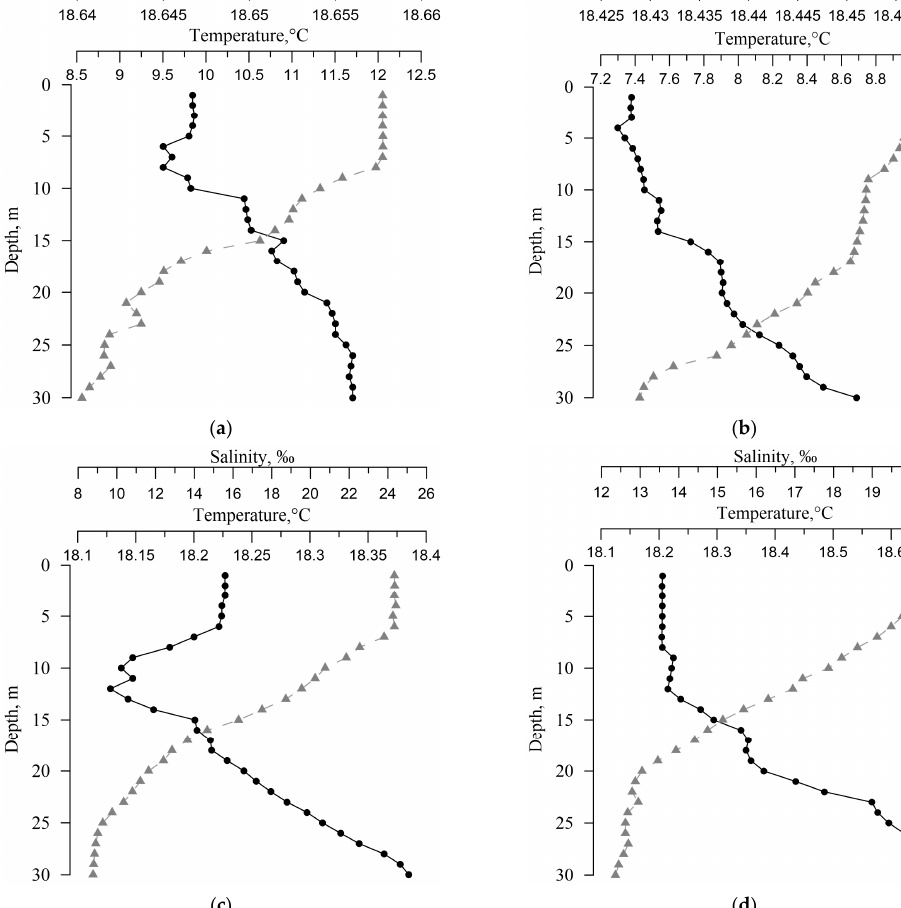
Figure 4. Salinity and temperature of seawater at different horizons: ( a ) winter 2021; ( b ) spring 2022; ( c ) summer 2022, ( d ) autumn 2022 (salinity ( ● ), temperature ( ▲ )).